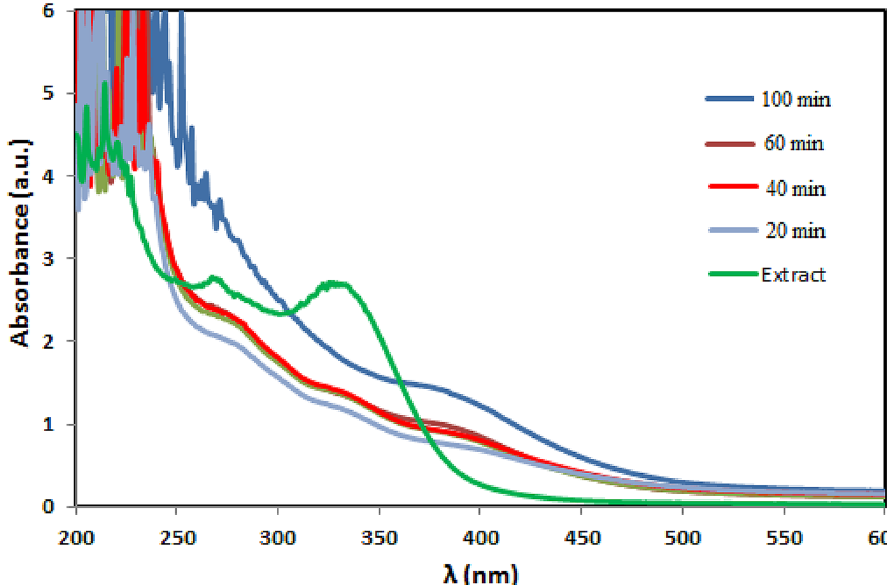
Figure 2. UV–Vis spectrum of biogenic CuO NPs using S. lavandulifolia extract.